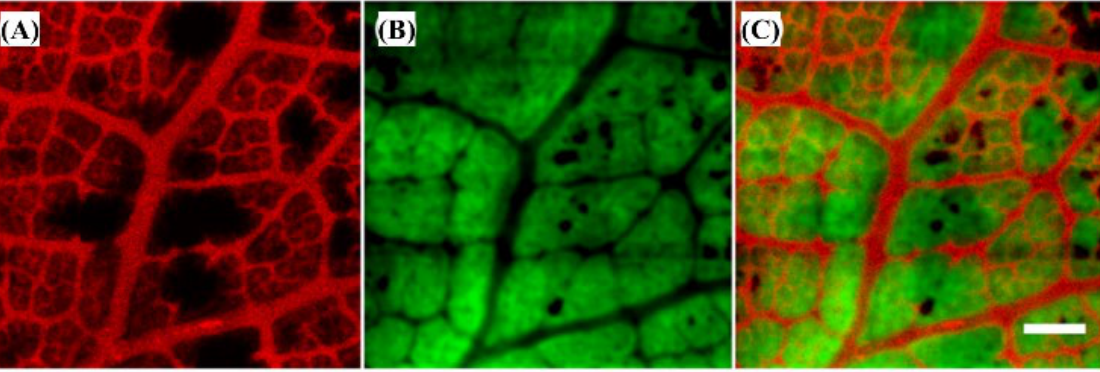
Figure 26. Bimodal photoacoustic and fluorescence imaging of a young rose leaf. ( A ) OR-PAM MAP image depicting the anthocyanin accumulation. ( B ) Chlorophylls autofluorescence image of the same region. ( C ) Combined image of the two contrast modes. Reprinted from Tservelakis et al., J. Microsc., 2016, 263, 3; 300–306 [44], with permission of Wiley Online Library.